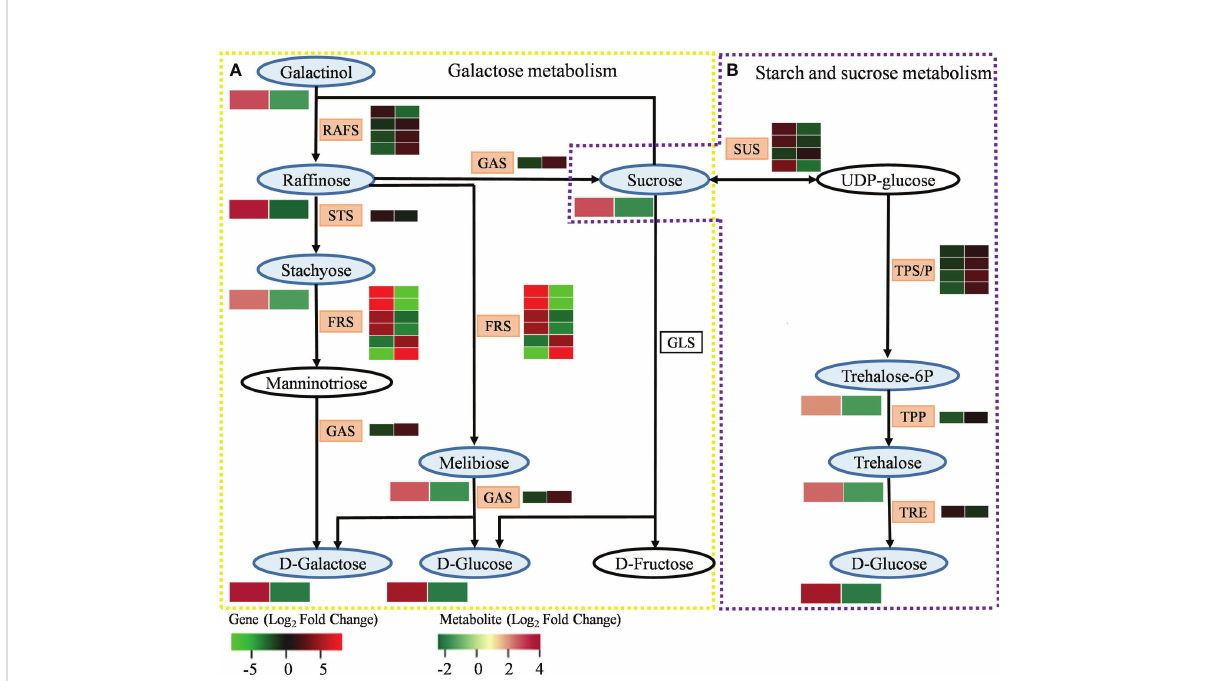
FIGURE 7 DEGs and DEMs involved in carbohydrate metabolism in response to exogenous addition of MT under drought stress. (A) Galactose metabolism. (B) Starch and sucrose metabolism. The blue and pink patterns represent the metabolites and genes that changed after exogenous addition of MT under drought stress, respectively. The rectangle is divided into two equal parts: the left of the rectangle represents DEGs or DEMs in “ CK vs. D ” ; the right of the rectangle represents DEGs or DEMs in “ D vs. MD. ” The colors in the rectangle represent the genes or metabolites regulated after exogenous addition of MT under drought stress (red indicates upregulation; green indicates downregulation; gray indicates